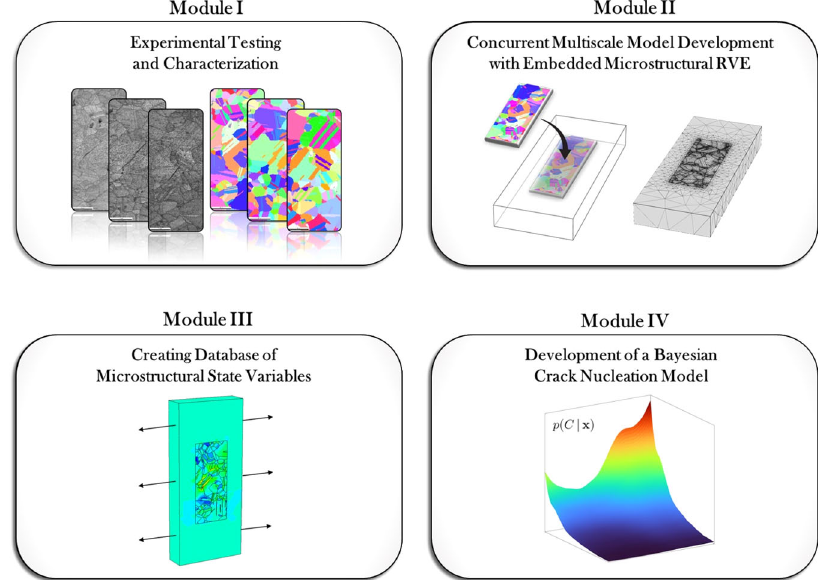
Fig. 1 Four modules comprising the pipeline for developing the data-driven crack nucleation model. (I) experimental testing and characterization data, (II) development of the concurrent multiscale model with embedded microstructural RVE, (III) creation of a database of microstructural state variables, and (IV) development of the Bayesian crack nucleation